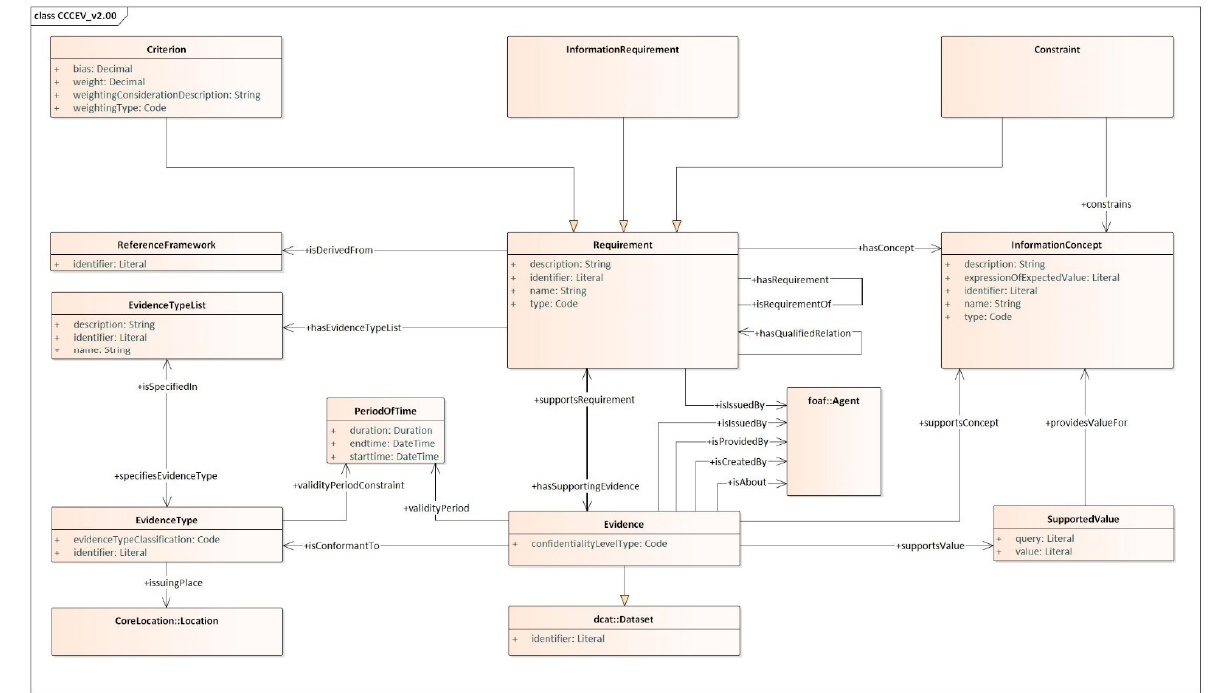
Figure 2. UML diagram of Core Criterion and Core Evidence Vocabulary v2.0.0 (adopted from [16]).